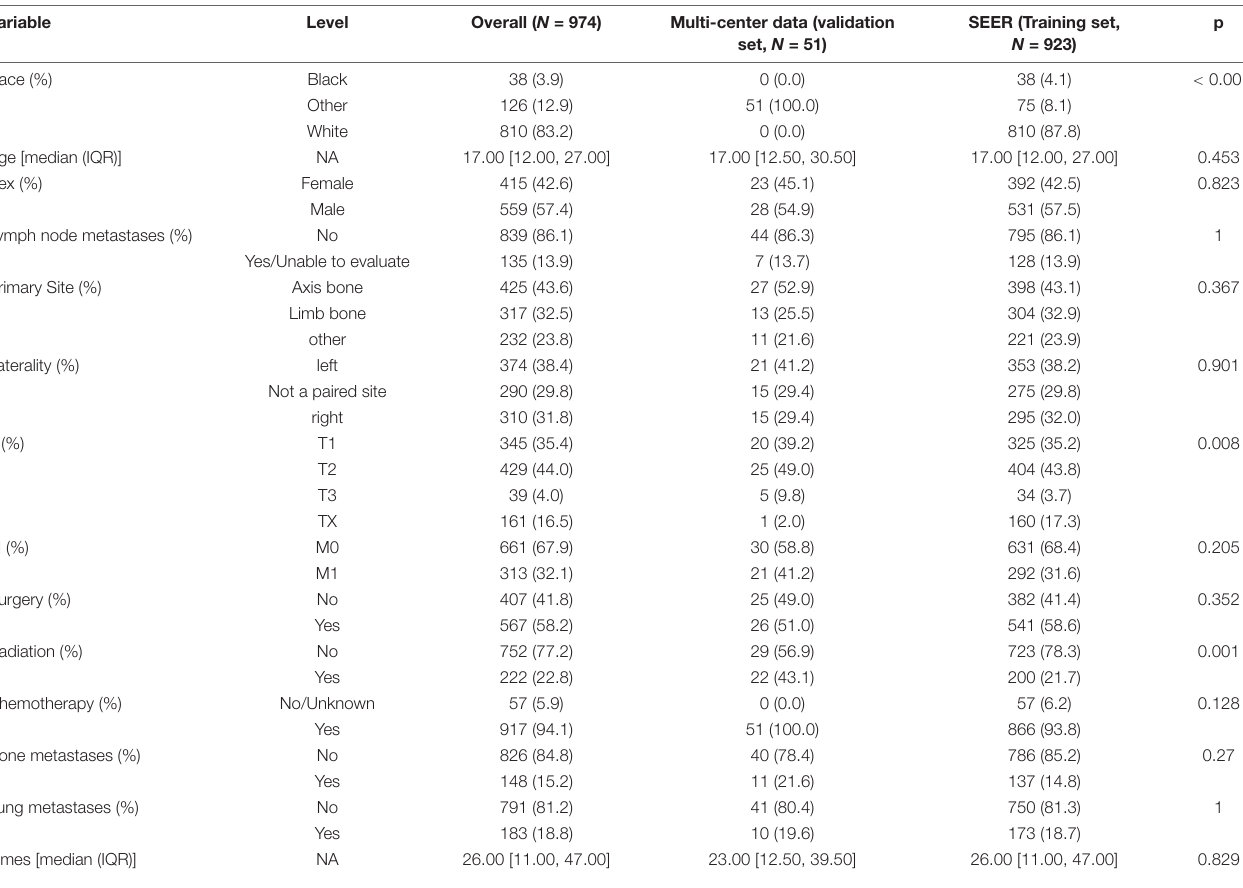
TABLE 1 | Baseline data table of the training and validation sets.